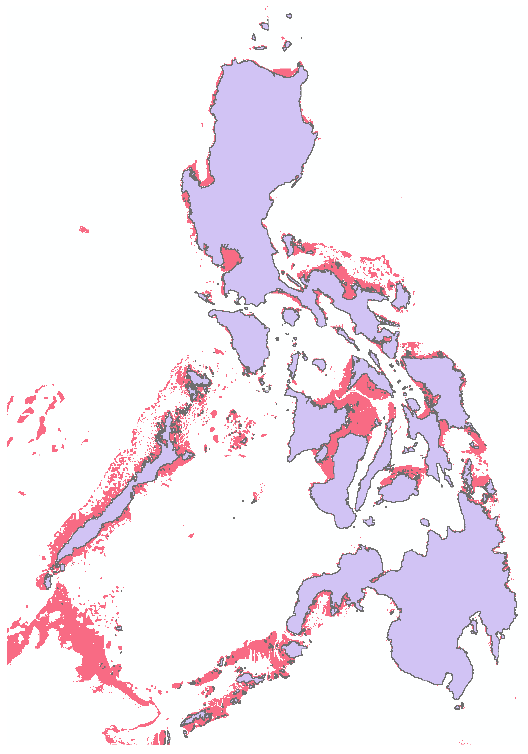
Figure 8. Bathymetry within 50 m.